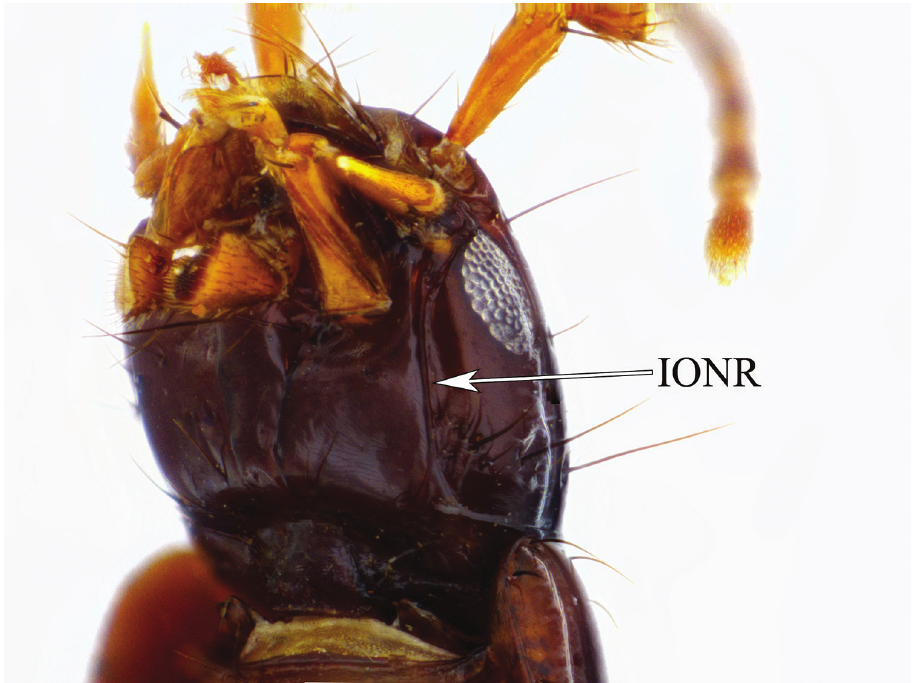
Figure 5. Lateroventral view of head of Quediopsis howensis Jenkins Shaw & Solodovnikov, sp. n. IONR = Infraorbital extension of nuchal